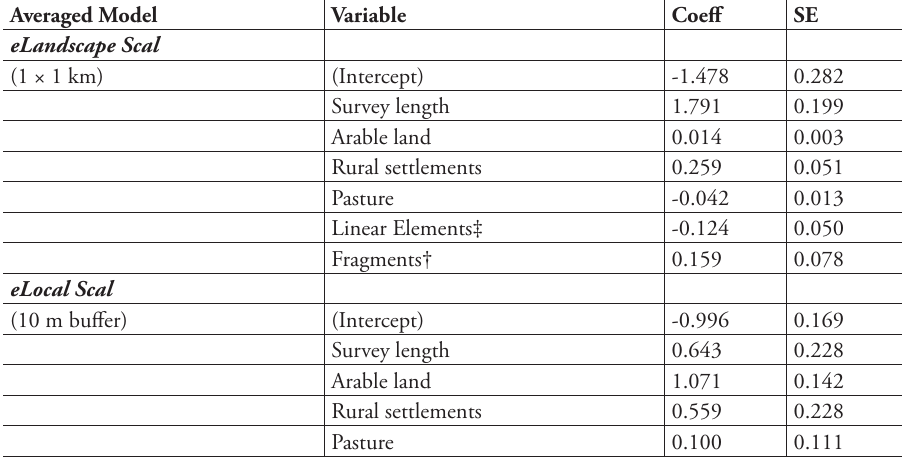
† = Number of fragments of arable land, ‡ = the sum of the length of streams and roads. Coeff = coefficient; SE = Standard error of